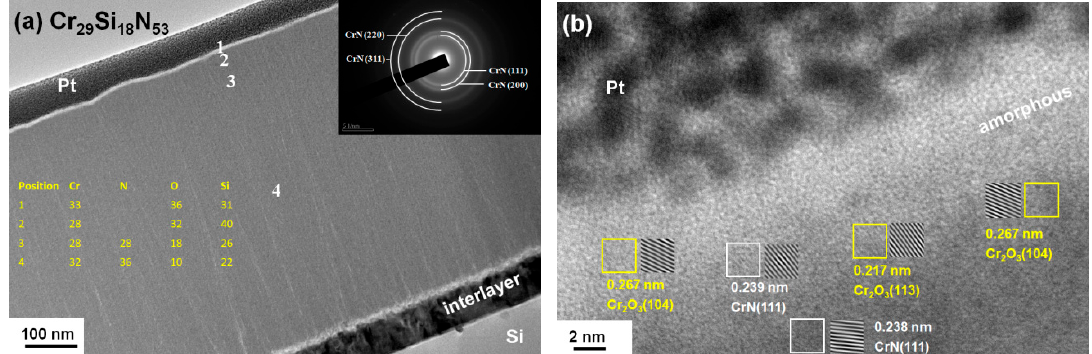
Figure 11. ( a ) Cross-sectional TEM image, selected-area diffraction pattern (inset), and EDS results (shown in yellow) of the Cr 29 Si 18 N 53 coating after annealing in 15 ppm O 2 –N 2 at 600 °C for 16 h; ( b ) the high-resolution TEM image.